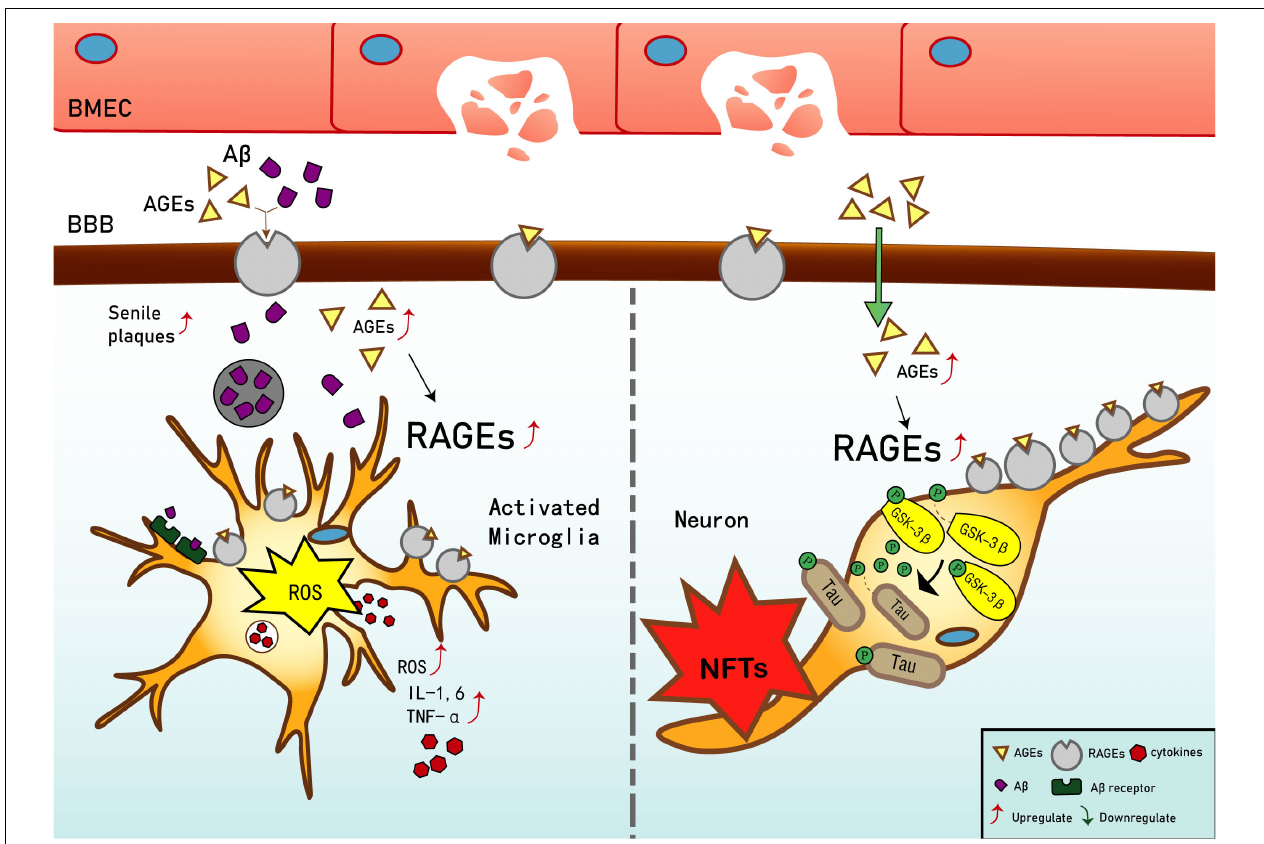
FIGURE 1 | Receptor of advanced glycation end products (RAGE) mediates the possible mechanism of Alzheimer’s disease (AD). Interaction of RAGE with advanced glycation end products (AGEs) and β -amyloid (A β ) allows them to cross the blood–brain barrier and enter the brain. A β deposition in the brain promotes the expression of tumor necrosis factor α (TNF- α ), interleukin (IL)-1, and IL-6, and exacerbates the inflammatory response. Increased binding of A β to RAGE after entering the brain can also upregulate RAGE expression, resulting in increased release of reactive oxygen species (ROS) and upregulation of A β expression, which then promotes the generation of senile plaques (SPs). The upregulation of RAGE exacerbates phosphorylation of tau protein and promotes the generation of neurofibrillary tangles (NFTs). AGEs and RAGE phosphorylate glycogen synthase kinase 3 (GSK-3 β ), which, in turn, exacerbates the phosphorylation of tau protein and promotes the generation of NFTs. Upregulation of A β and tau protein levels promote the occurrence and development of